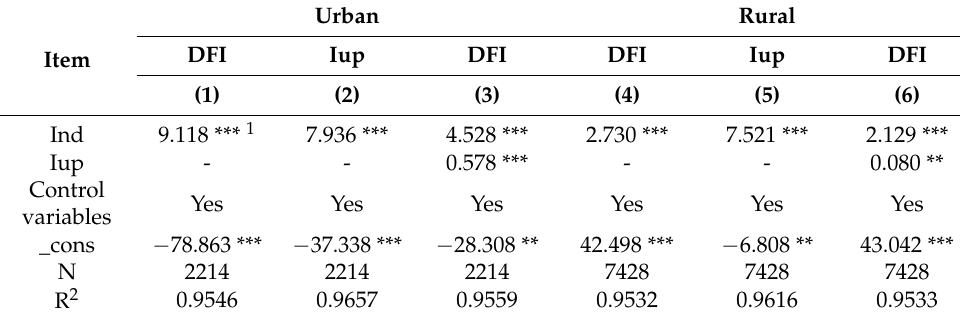
Table 6. Mechanisms analysis of industrial